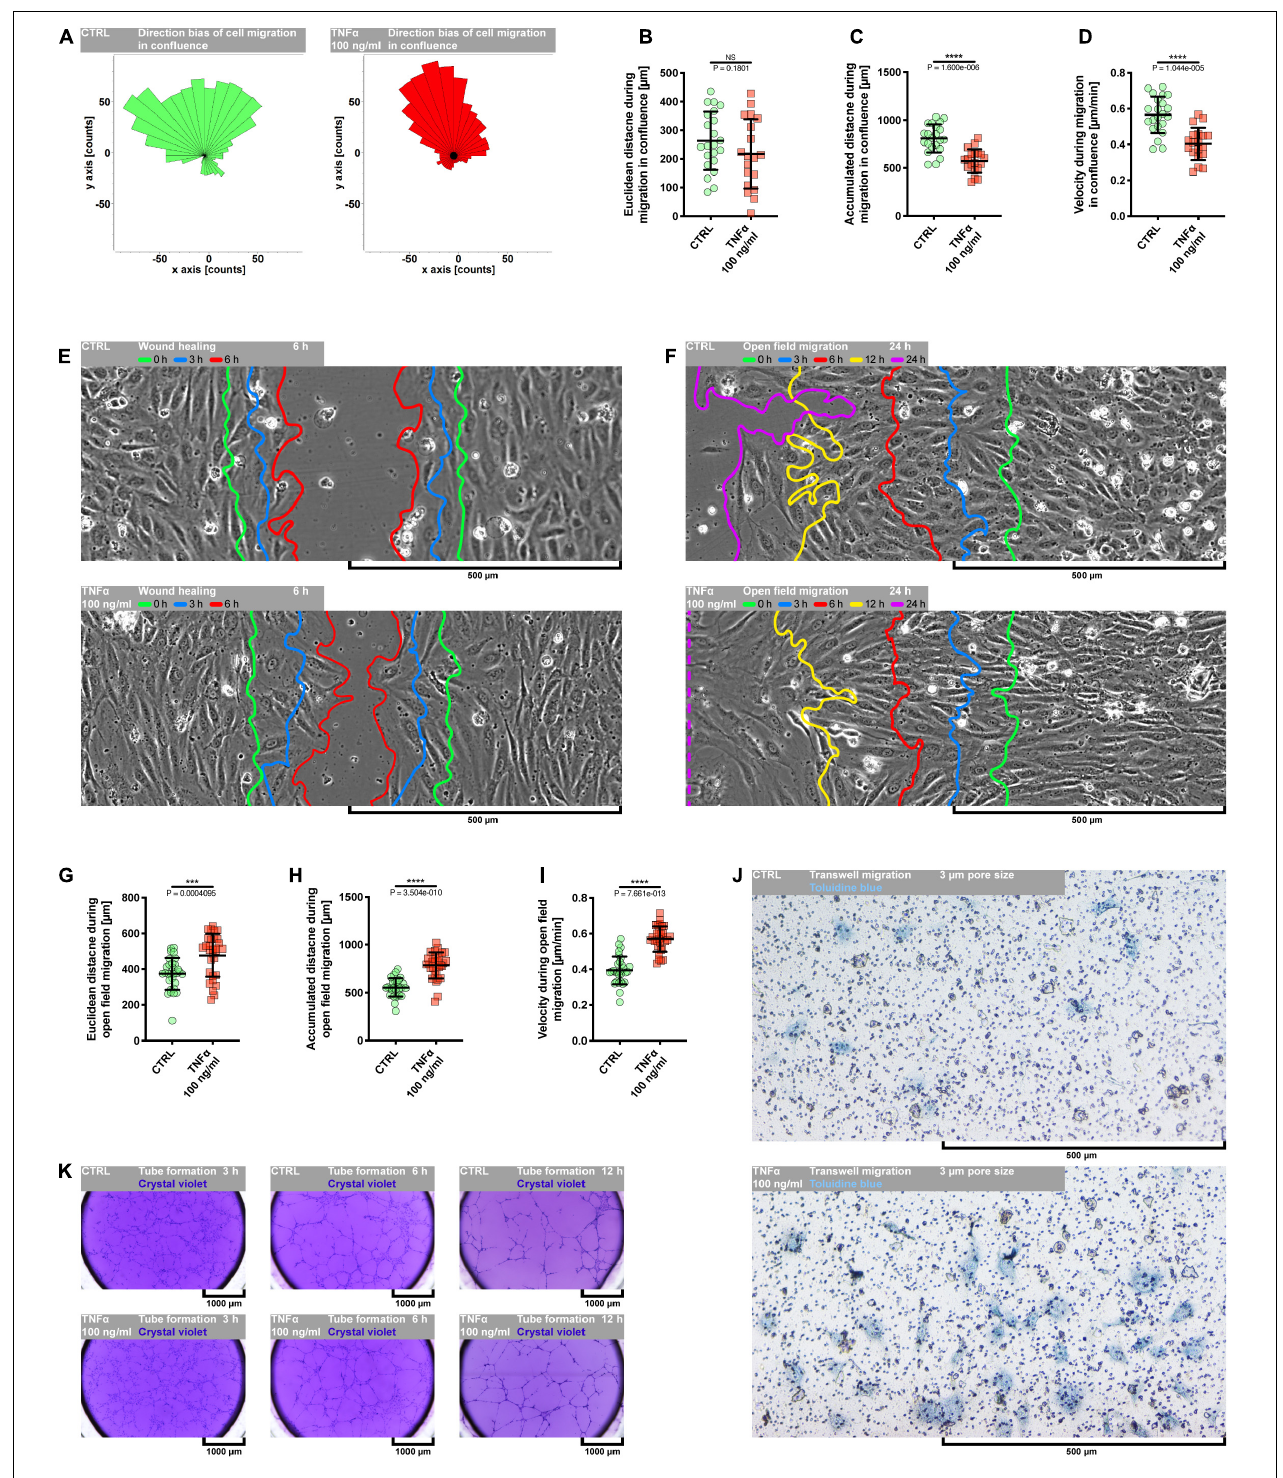
FIGURE 2 | Effect of TNF α on migration of pHCAECs. (A) Rose plot presenting direction bias of pHCAEC migration in confluence within 24 h. CTRL refers to the control (left panel), TNF α 100 ng/ml to cells treated with rh TNF α (right panel), ** to p < 0.01, **** to p < 0.0001, as determined by Rayleigh test. (B) Euclidean distance of pHCAECs during 24-h migration in 100% confluence. CTRL refers to the control, TNF α 100 ng/ml to cells treated with rh TNF α , NS to non-significant to the control, as determined by unpaired t -test. (C) Accumulated distance of pHCAECs during 24-h migration in 100%